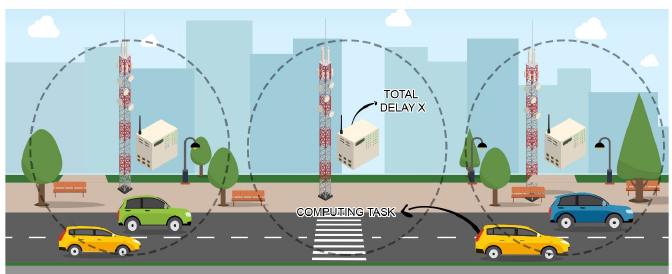
Figure 1. Vehicular network (VN) with mobile edge computing (MEC)